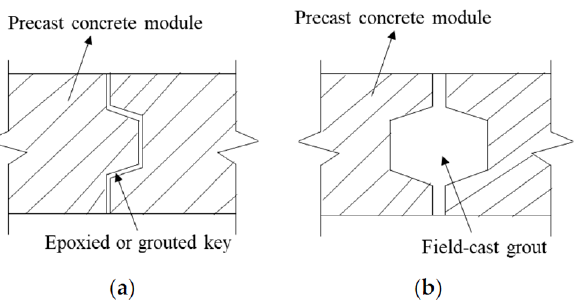
Figure 1. Types of shear keys: ( a ) male-to-female key; ( b ) female-to-female